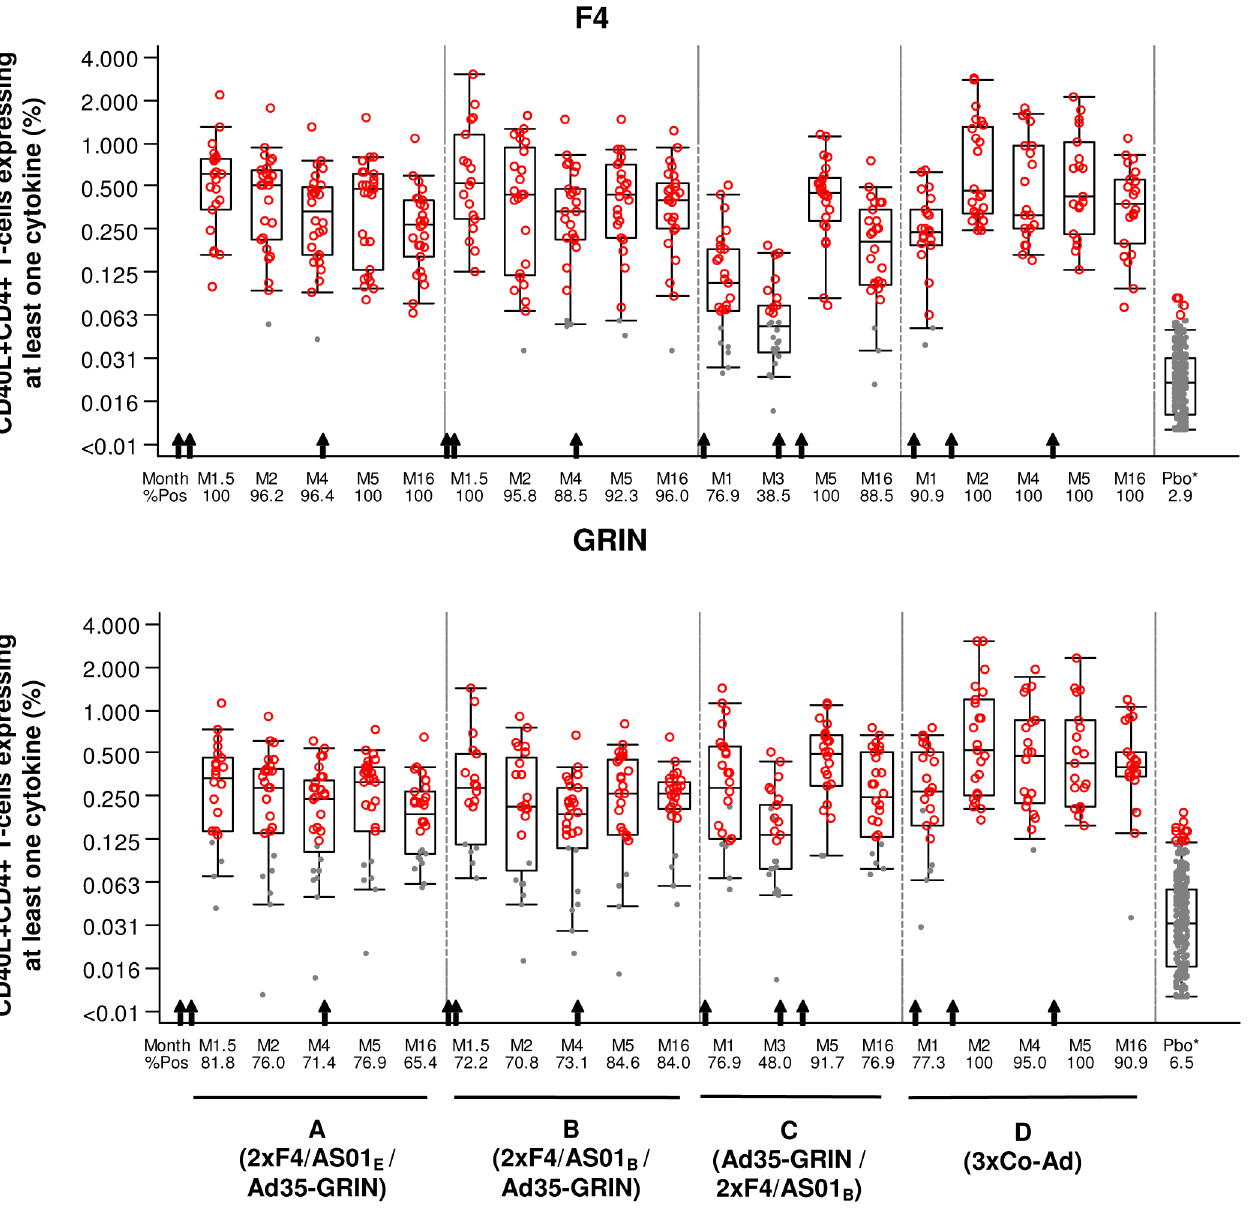
Fig 5. Kinetics of CD40L+CD4+ T-cell responses. The magnitude of the CD4+ T cells expressing CD40L and at least one cytokine among IL-2, TNF- α and IFN- γ is shown for A. F4 (any of p24+RT+Nef+p17 peptide pools) and B. GRIN (any of Gag+RT+Int+Nef peptides pools). M: Months. Gray dots: response below the cut-off to any of the 8 peptide pools; red circles: response above the cut-off to any of the 8 peptide pools. All baseline and placebo (Pbo * ) groups are combined in the far right box plot. The arrows indicate when the vaccines were given for each group (lower